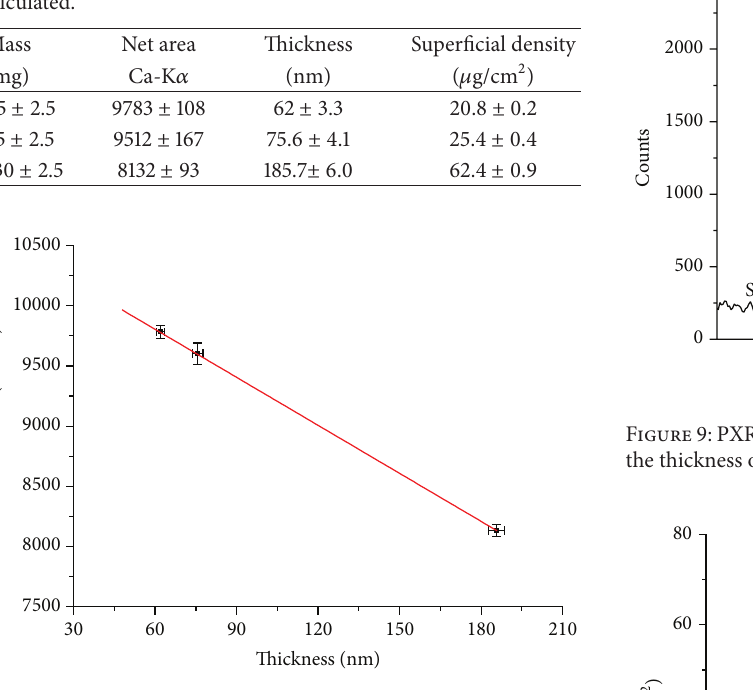
Figure 8: Vanadium thickness on the glass substrate calculated using a calibration equation.